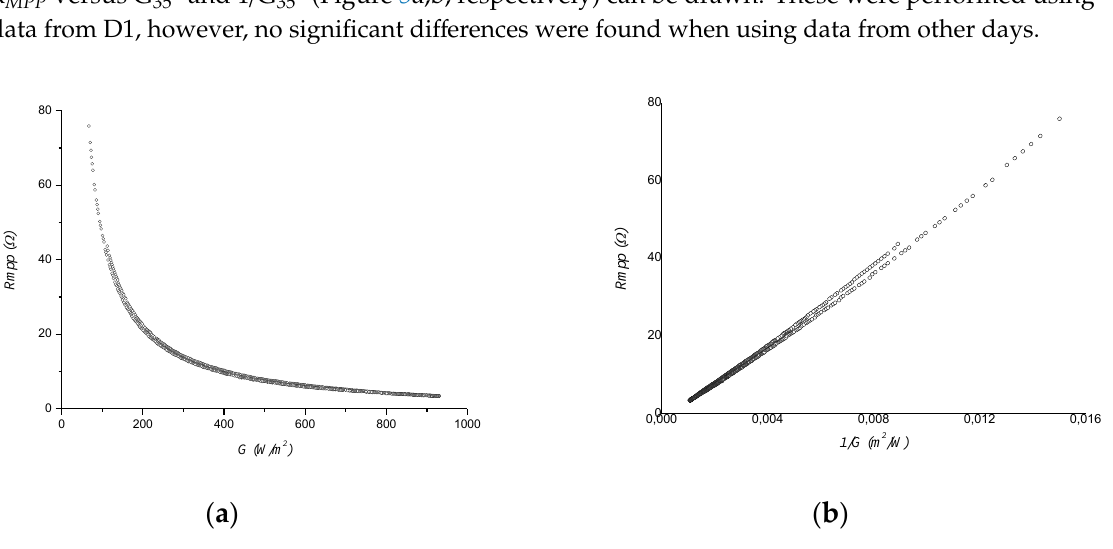
Figure 4. Boost DC / DC converter used in the simulations. Figure 4. Boost DC/DC converter used in the simulations.